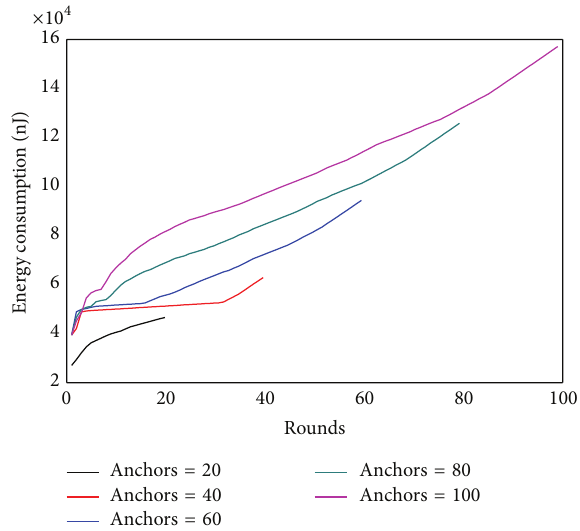
Figure 24: Maximum energy consumption under different numbers of anchor (theoretical